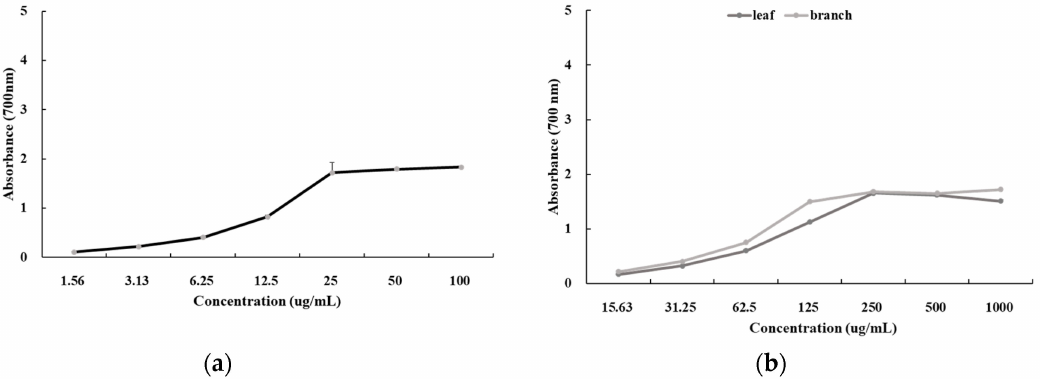
Figure 7. Reducing power of ( a ) L-ascorbic acid and ( b ) hot-water extracts from S. samarangense . An appropriate amount of ascorbic acid was used as a positive control. The results were expressed as the mean ± SD of data obtained from three independent experiments.